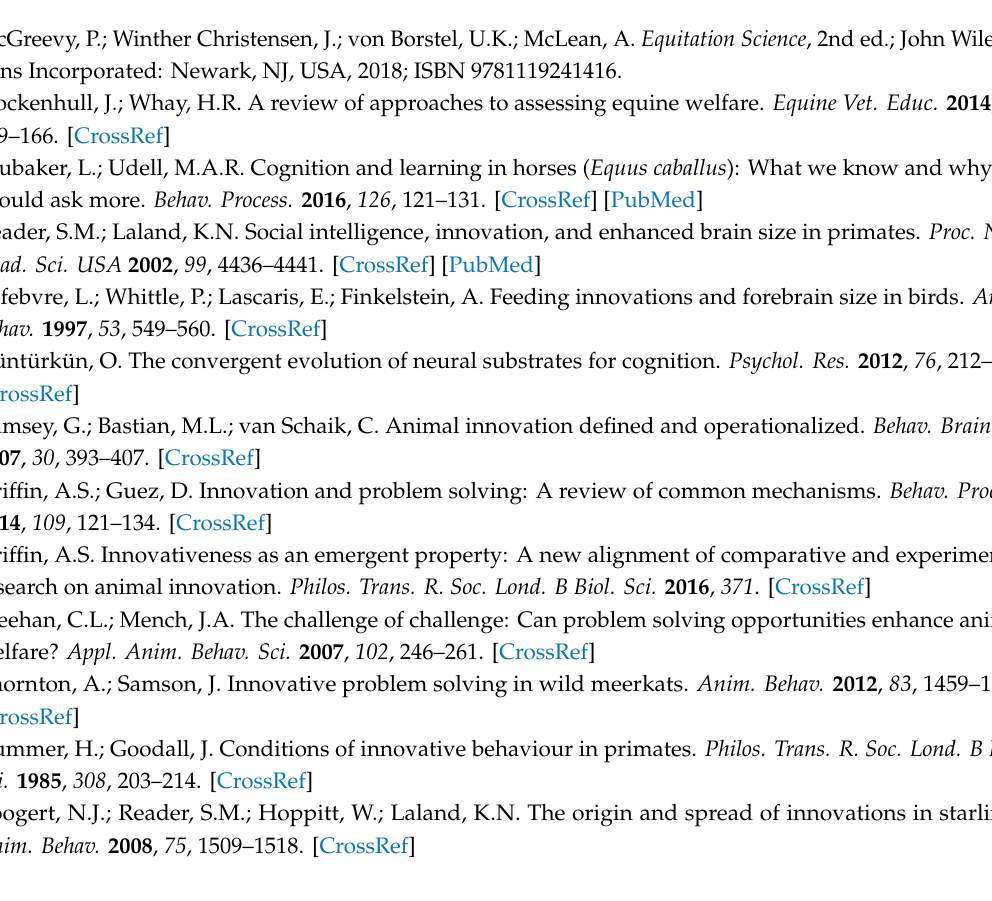
Figure S1: Perspective view of the horse’s box, type B; Figure S2: Interior view of the horses’ box, type B; Figure S3: Construction of the feeder; Figure S4: Evaluation method of the horses’ sensory laterality; Figure S5: Horse lateral approach with (a) the left eye, (b) the right eye or (c) in a neutral position; Table S1: Ratings of the horses’ motor laterality and z-scores; Table S2: Ratings of the horses’ sensory laterality and z-scores; Figure S6: Motor and sensory laterality of the test horses; File S2: Complete and reduced Generalized linear mixed